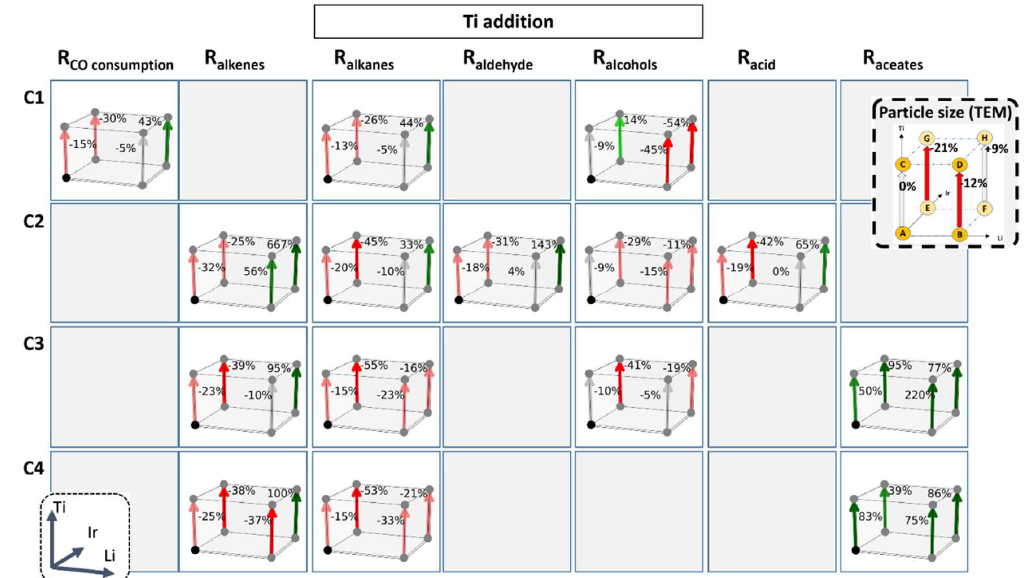
Figure 7. The studied effect of target promoter Ti in Exp 1 (T = 270 °C, P = 50 bar, total flow = 43 mL/min, H 2 :CO = 48:22 %V). The colors of the arrows and the cubes are sorted as in Figures 4 and 5. The effect of Ti addition on average particle size is shown on the right. For all of the compared catalyst pairs, an increase in the rate of acetates, depicted by green arrows, is observed. Here, an even more complicated pattern arises than for Ir and Li. Only the formation of acetates increases consistently across all four pairs with the addition of Ti, whereas ethanol formation decreases for all pairs.